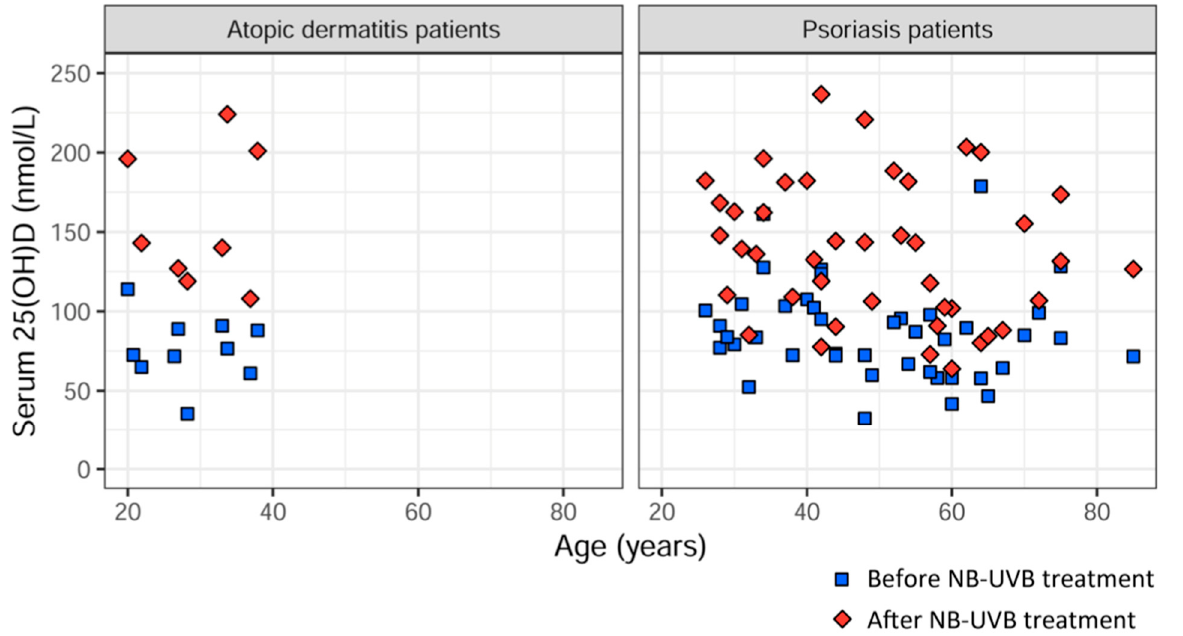
Figure 2. 25(OH)D serum levels in atopic dermatitis (AD) patients and psoriasis patients before and after narrow ‐ band UVB phototherapy. The difference between delta 25(OH)D was statistically significant between AD patients and psoriasis patients ( p = 0.033).